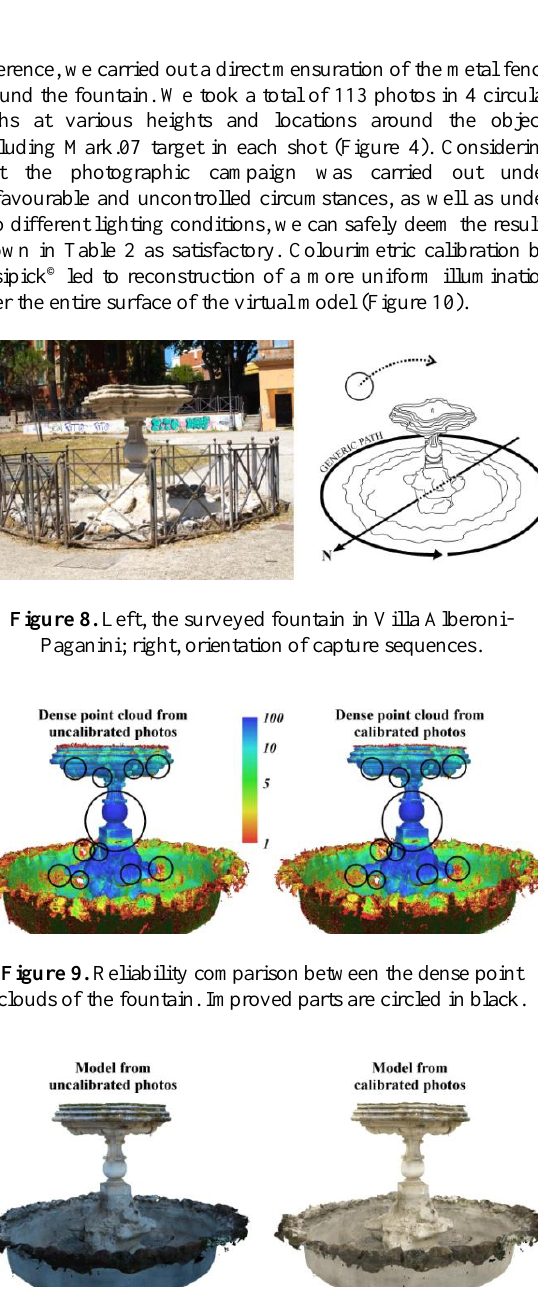
Figure 10. Comparison between the textured three-dimensional models of the